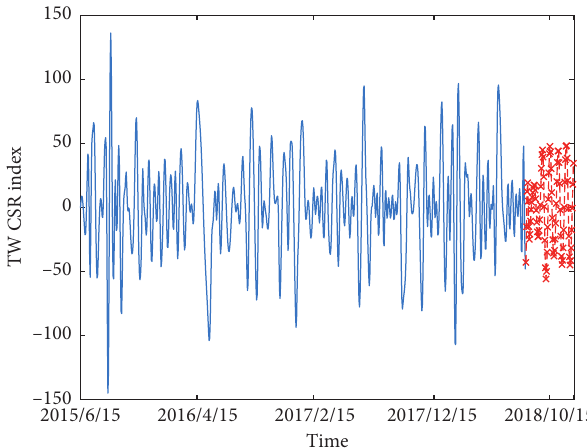
Figure 9: LSTM prediction results for IMF2.